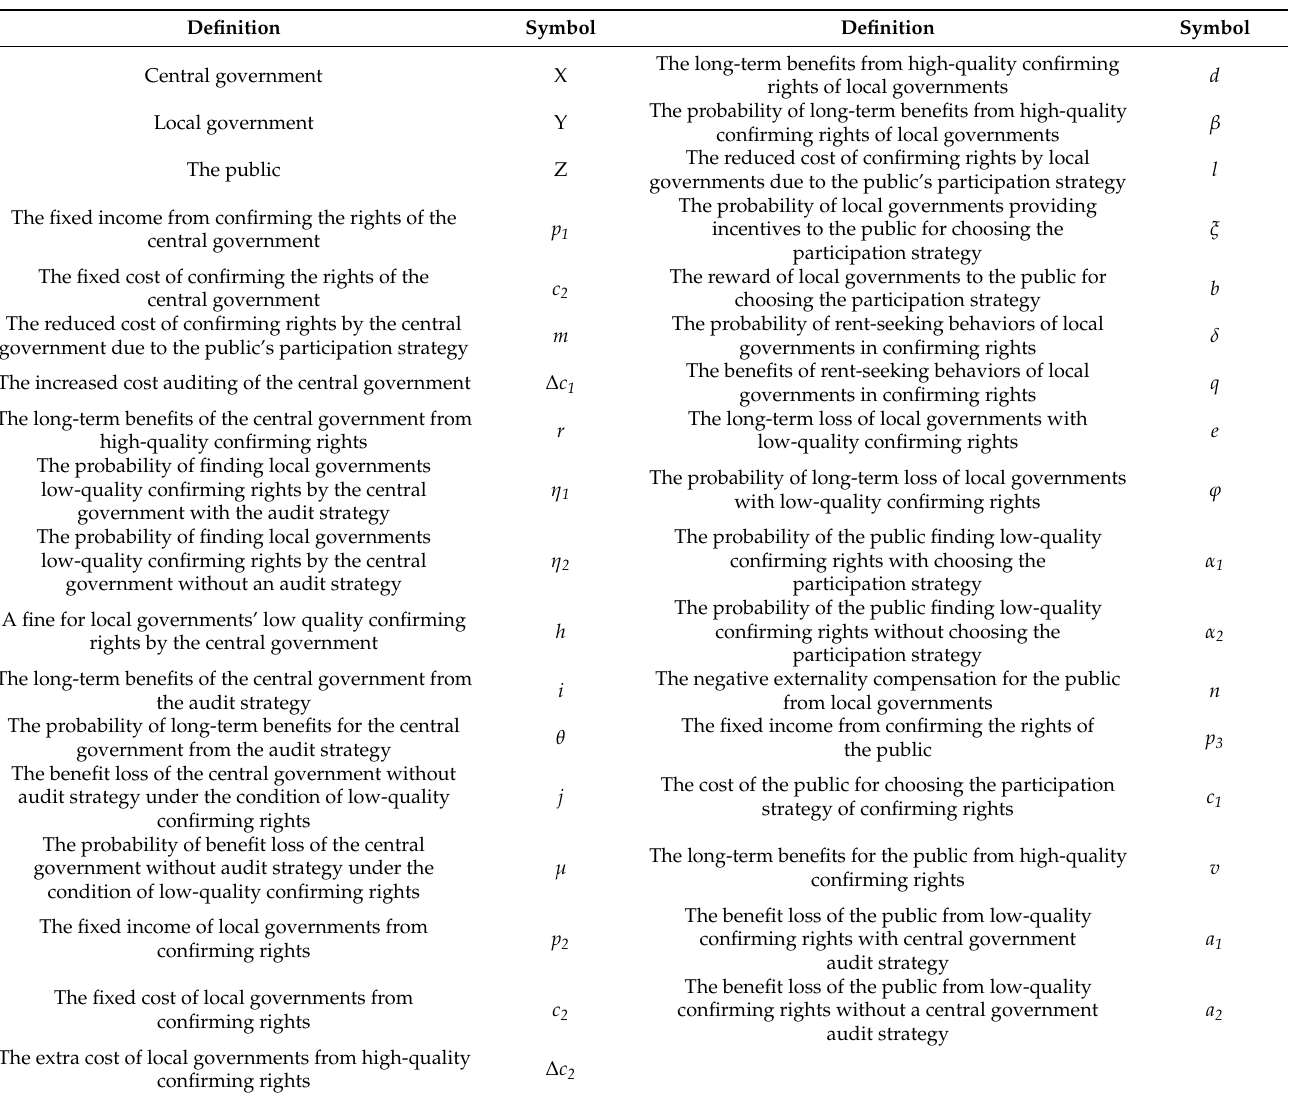
Table 1. Variable